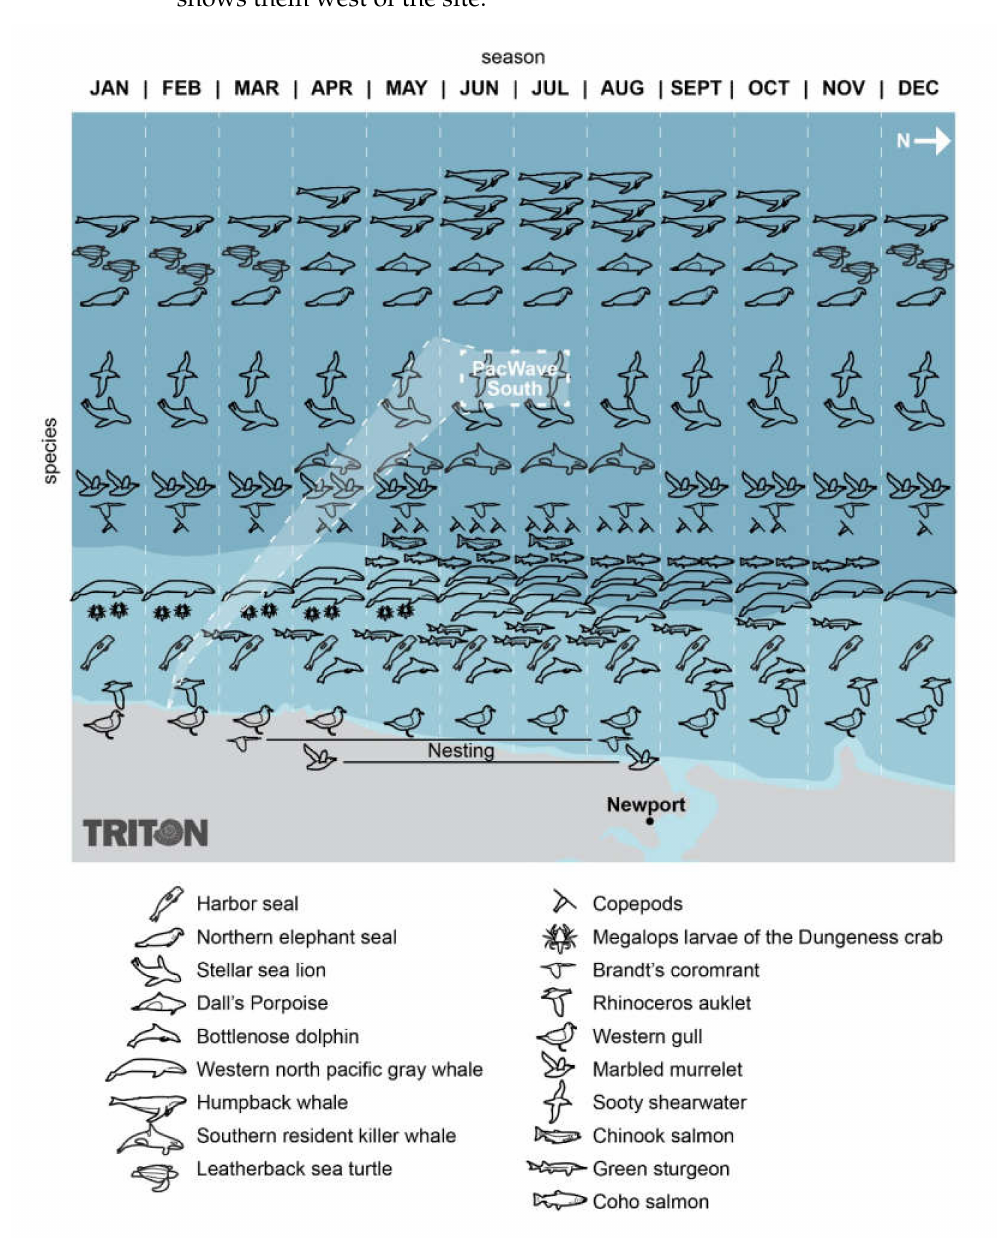
Figure 2. The placement of each species is spatially representative of the various regions where they might be found at the PacWave marine energy test site in Newport, OR. At different times of the year, some species are in higher abundance. During these periods of time it may be more beneficial to target specific species to monitor their behavior and physiological responses to the marine energy device, or changes related to a specific environmental stressor in the space where species are most likely to be found. This illustration does not include the entirety of species included in the environmental impact assessment that informed the permitting process for this test site (illustration by Stephanie King,